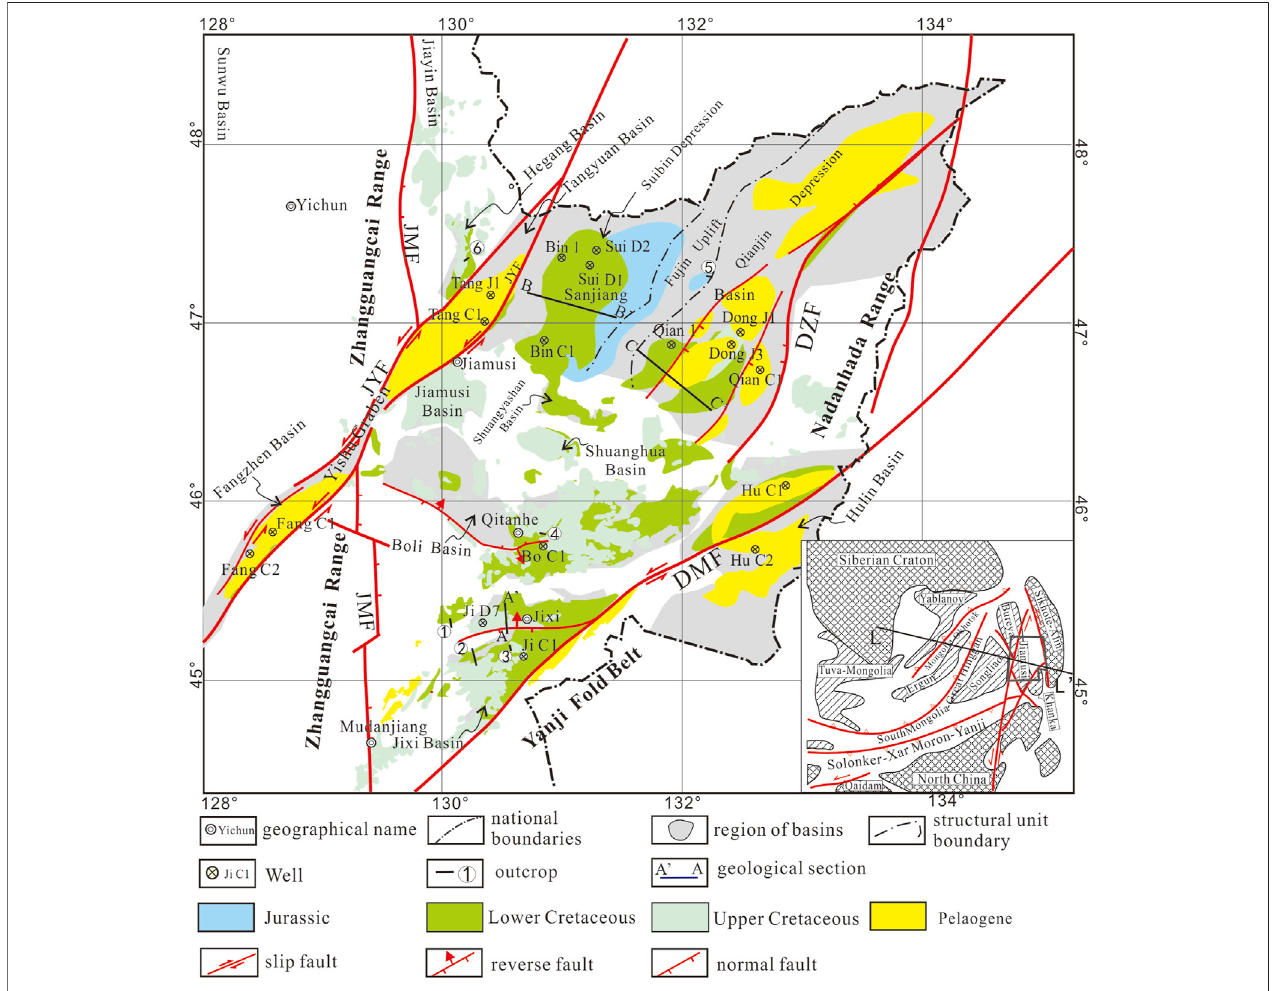
FIGURE 1 | Distribution of Mesozoic-Paleogene sedimentary strata and tectonic framework map of the EHLJ (modi fi ed after Zhang et al., 2015; Zhao et al., 2017; JiaandZheng,2010;Menetal.,2010),showingthelocationsofseismicpro fi les,outcrops,and drillholes.Atectonicsketchmap(inset,bottomright)showstheprimary subdivisions of central and eastern Asia and the location of the study areas (modi fi ed after Zhou et al., 2009). Abbreviations: JYF, jiamusi-yitong fault; JMF, jiayin- mudanjiang fault; DZF, dahezhen fault; DMF, dunhua-mishan fault.